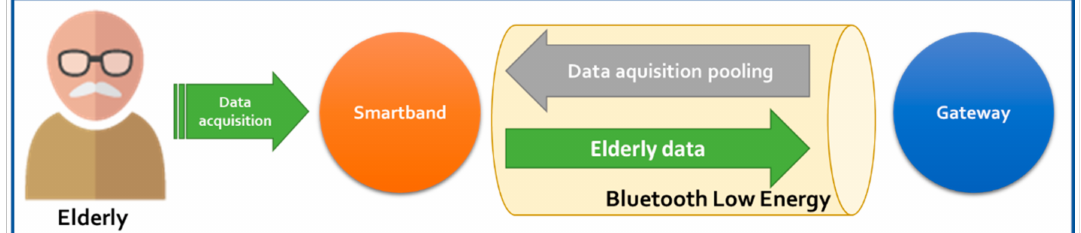
Figure 2. Sensing